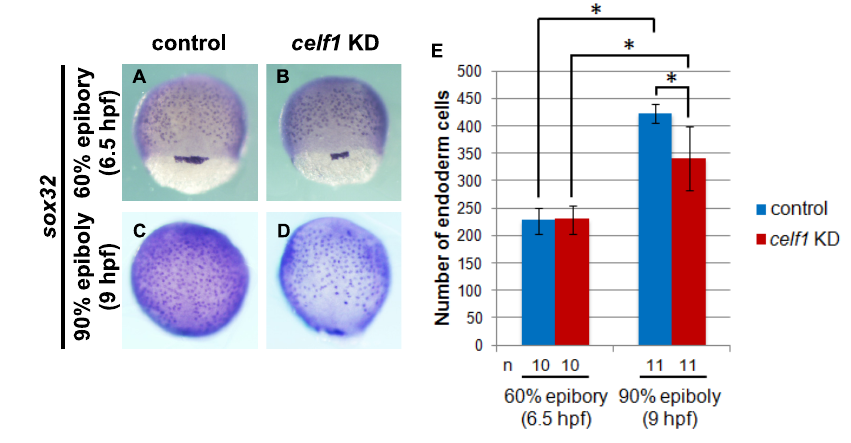
Figure 3. celf1 controls endoderm cell growth during gastrulation. ( A – D ) sox32 expression in endoderm cells at 6.5 and 9 hpf in control and celf1 KD embryos. Anterior to the top. ( E ) The number of endoderm cells was the same at 6.5 hpf but reduced at 9 hpf. Asterisks indicate statistically significant differences (* p < 0.05).